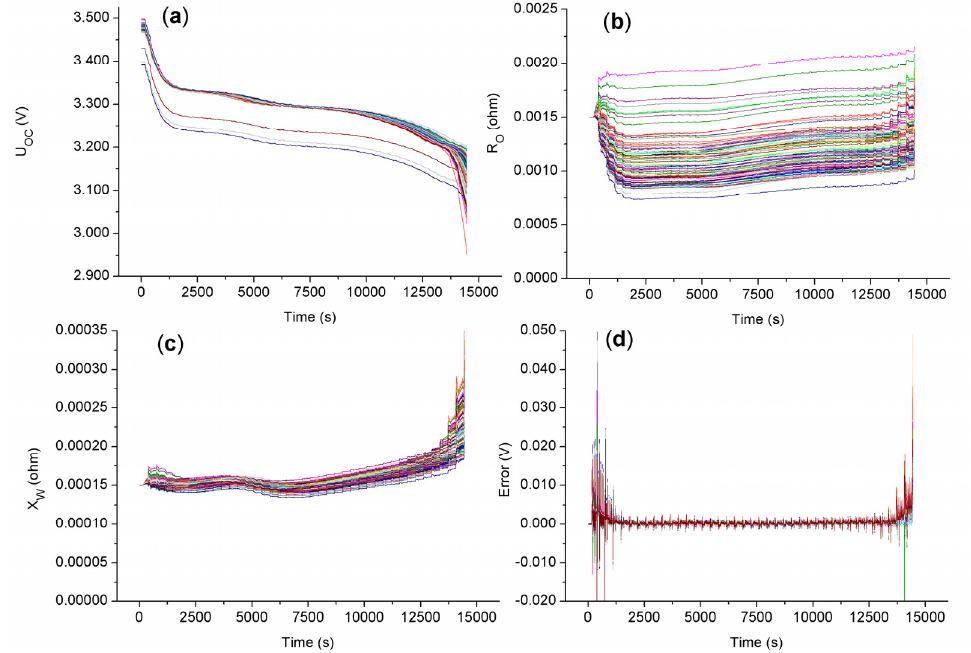
Figure 9. Battery capacities and